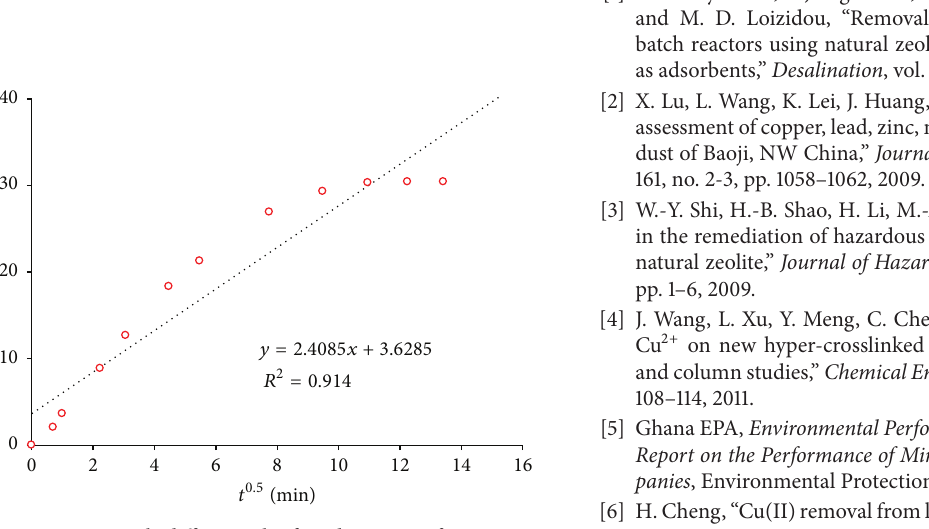
Figure 15: Intraparticle diffusion plot for adsorption of copper ions onto CaHBSW.